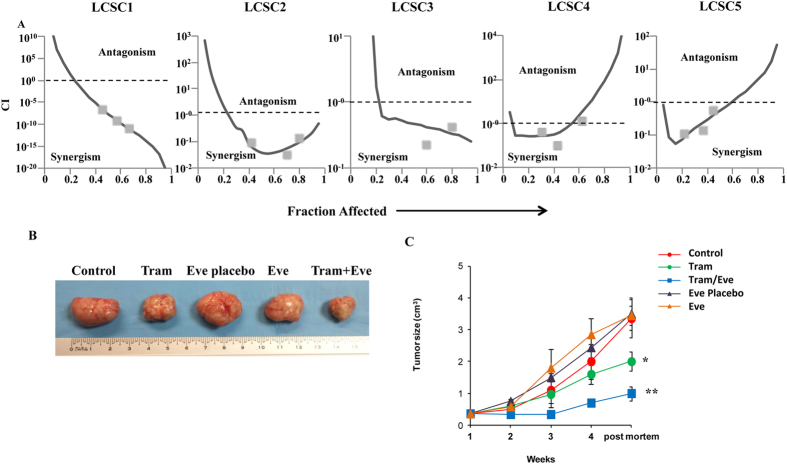
Effects of single and combined MEK and mTOR inhibition in LCSC.(A) Cells obtained from lung cancer spheres (LCSC) dissociation were plated in 96-well flat-bottom plates; Trametinib and Everolimus were added at their final concentration (1–1000 nM), as single agents or in a fixed dose-ratio combination (1:1). CI were calculated by conservative isobologram analysis for experimental data and plotted against the fraction affected. (B) Macroscopic image of subcutaneous tumor xenografts was obtained after injection of CR-CSCs. Mice were treated for 3 weeks with Vehicle or Placebo (Control or Eve placebo), Trametinib (Tram), Everolimus (Eve) alone or in combination (Tram/Eve). (C) Size of subcutaneous tumor xenografts was obtained in mice treated as in B. Data represents mean ± S.D. of three independent experiments. *p = 0.0009 for the comparison between control and Trametinib-treatment, **p for combined treatment with Trametinib and Everolimus as compared to either vehicle control (p = 0.0001) or single agent treatment (p = 0.003 for the comparison between Trametinib and combination, p = 0.0026 for the comparison between Everolimus and combination).